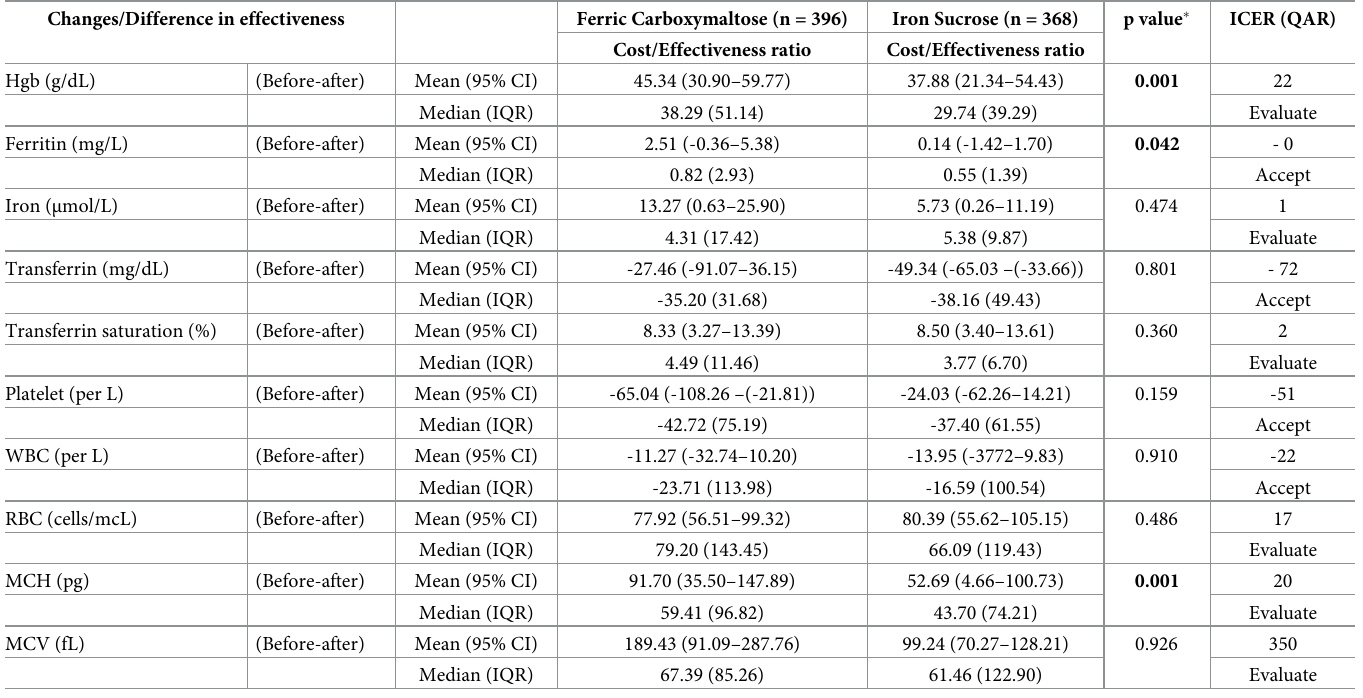
Table 5. Cost-economic analysis comparison between patients in the two treatment arms. Changes/Difference in